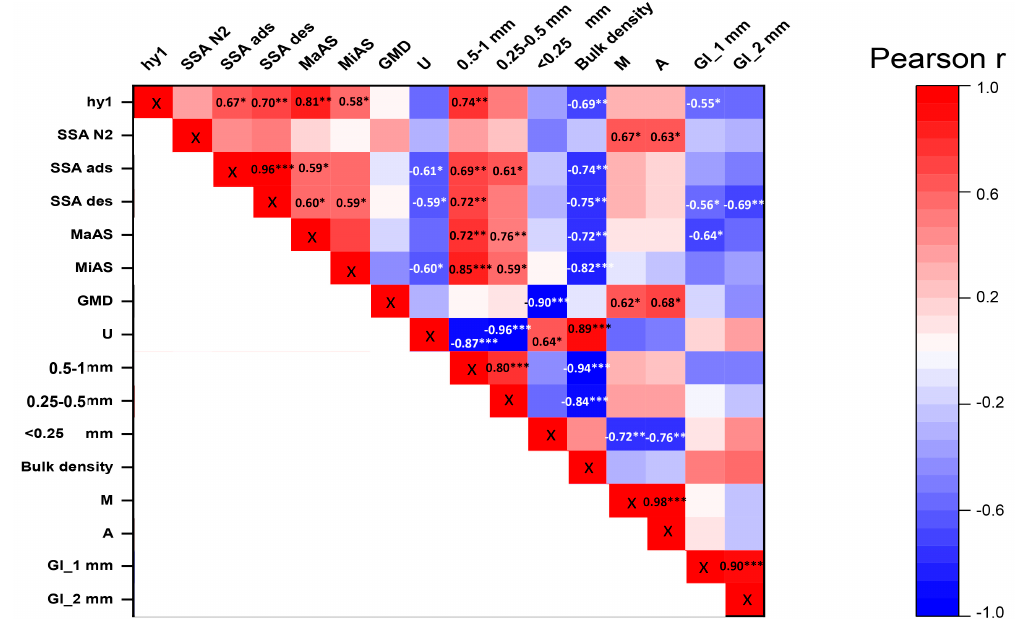
Figure 7. Pearson correlation analysis ( r ) between the investigated soil physical and biological parameters for the di ff erent treatments over the course of the study. The used abbreviations are the following: hy 1 is the hygroscopic water content, SSA N2 is the soil specific surface area measured using nitrogen gas, SSA ads and SSA des are the soil specific surface areas determined using water vapor adsorption and desorption data, respectively, MaAS is the macroaggregate stability, MiAS is the microaggregate stability, GMD is the geometric mean diameter of soil aggregate, U is the ratio of the 10% and 60% finer soil aggregate sizes ( d10 / d60 ), M is the intensity of AMF root colonization, A is the arbusculum richness of the root system, Gl_1 mm and Gl_2 mm are the easily-extractable glomalin-related soil protein in < 1 mm and 1–2 mm soil fractions, of the investigated soil samples, respectively. Correlation is significant * at the 0.05, ** at the 0.01, and *** at the 0.001